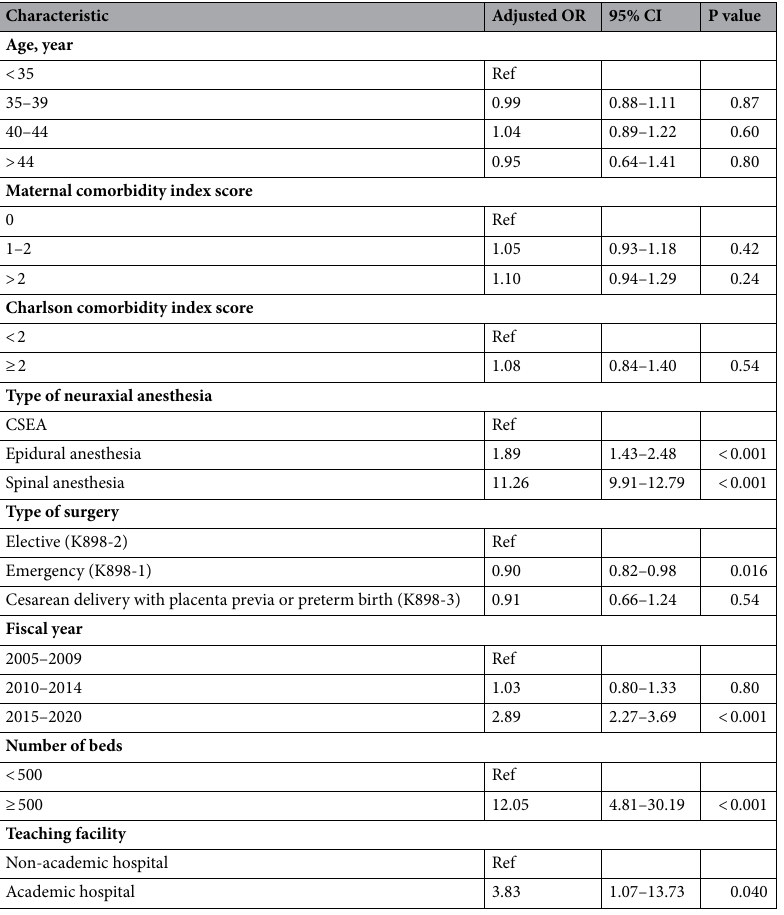
Table 4. Characteristics associated with neuraxial morphine use for cesarean deliveries. Institutions with less than 10 cases of cesarean delivery (956 sites; n = 3886) were excluded from the multilevel logistic regression analysis to stabilize the statistical model (1319 sites; n = 61,322). The area under the receiver-operating- characteristic curve of the model is 0.69. CI confidence interval, CSEA combined spinal–epidural anesthesia, OR odds